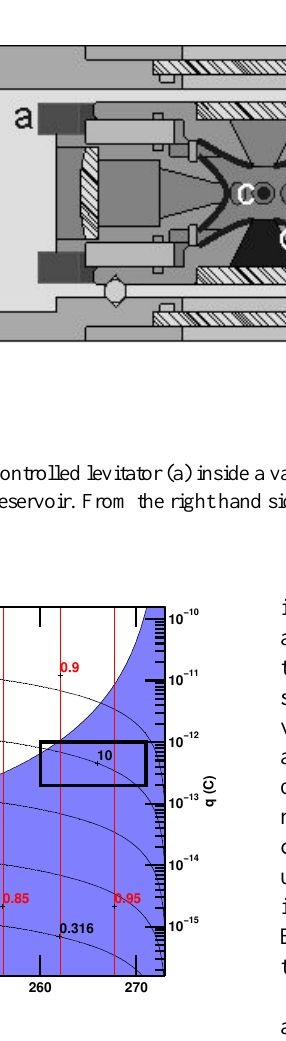
Fig. 3. Terminal radius ( µ m) for a charged droplet above an ice-surface, shown as black contours. The red lines show the ratio between ice saturation pressure and water saturation pressure, which only depends on temperature. The colored area shows where the droplet charge is below the Rayleigh instability limit, and the rectangle roughly shows the part of the phase diagram that we can access in these experiments.